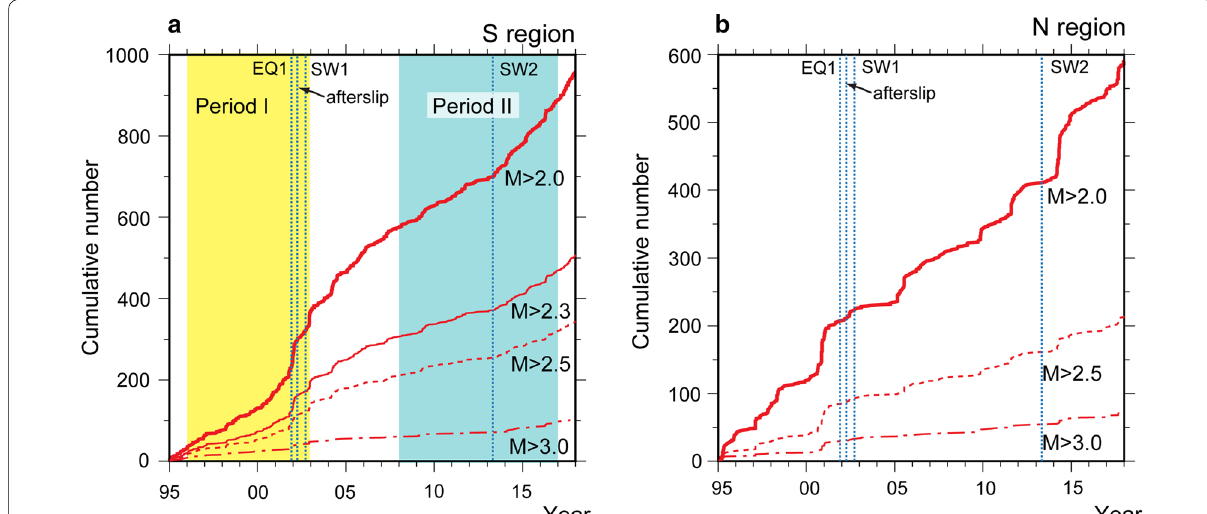
Fig. 3 Cumulative number of earthquakes since 1995 near Iriomote Island. a Cumulative number of earthquakes in the S region. The location of this area is shown in Fig. 2. The bold line, solid line, dotted line, and dot-dash line denote the cumulative number of earthquakes with magnitudes over 2.0, 2.3, 2.5, and 3.0, respectively. The yellow rectangle area and green rectangle area show the Period I (from January 1996 to December 2003) and Period II (January 2008 to December 2016) results, respectively. Blue dotted lines show the occurrence of the Eq1, afterslip, SW1, and SW2. b The same as a but in the N